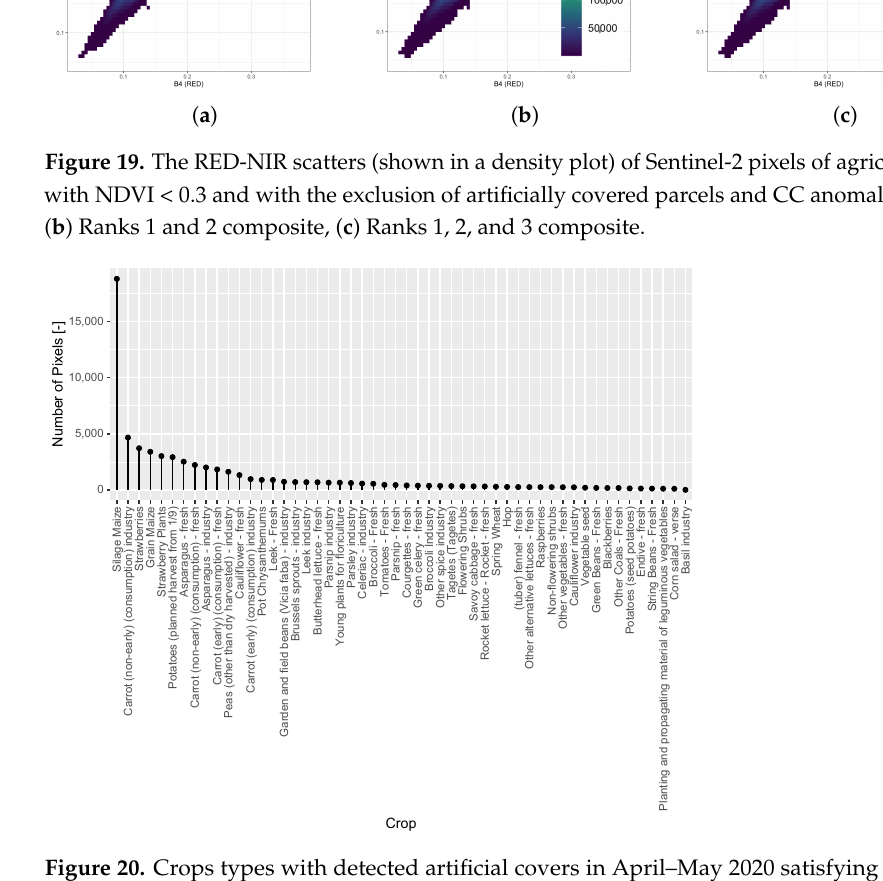
Figure 20. Crops types with detected artificial covers in April–May 2020 satisfying NDVI < 0.3 (a composite of the 3 top ranked acquisition